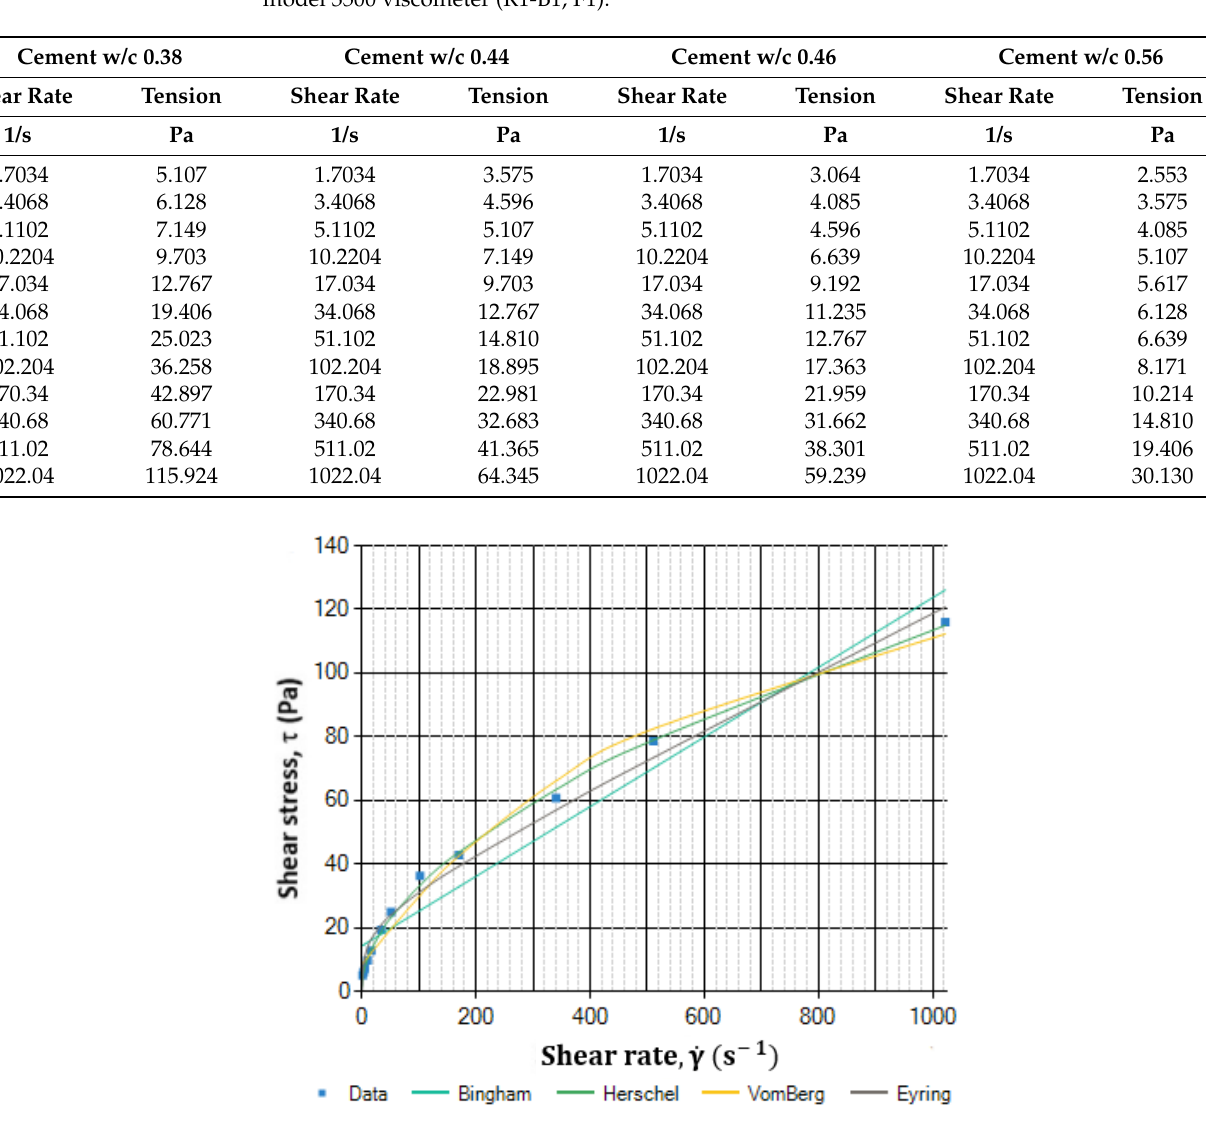
Figure 2. Comparison of the selected rheological models, cement w/c 0.38.